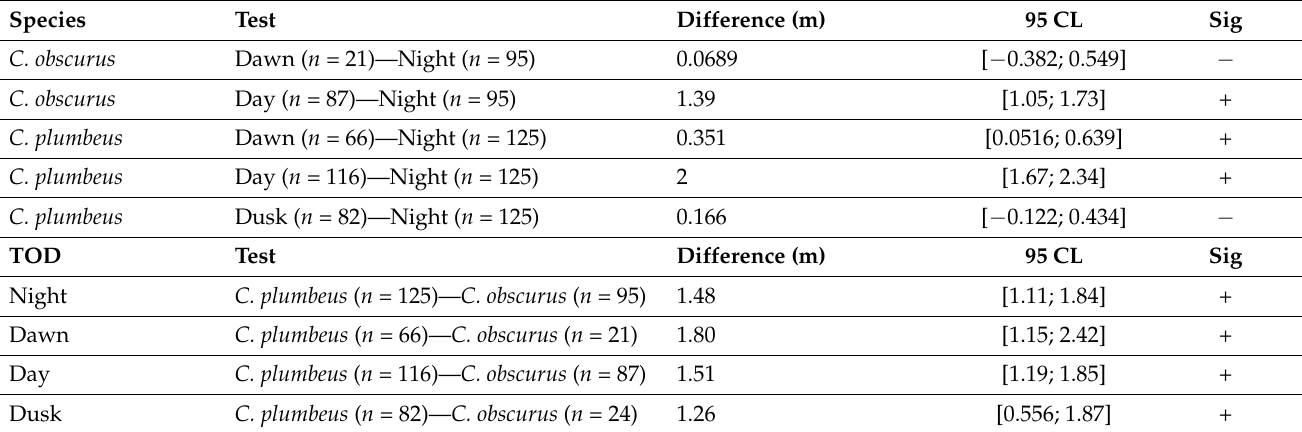
Figure 2. Median depth by the time of day for C. obscurus and C. plumbeus . The upper and lower limits of boxes represent the 75th and 25th percentiles, respectively. Horizontal lines represent the median value. Table 3. Unpaired Hedges’ g test among species and time of day